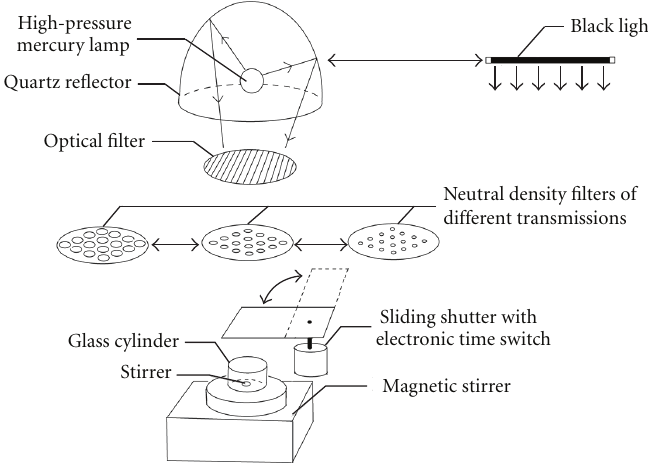
Figure 2: Schematic diagram of the photoreactor